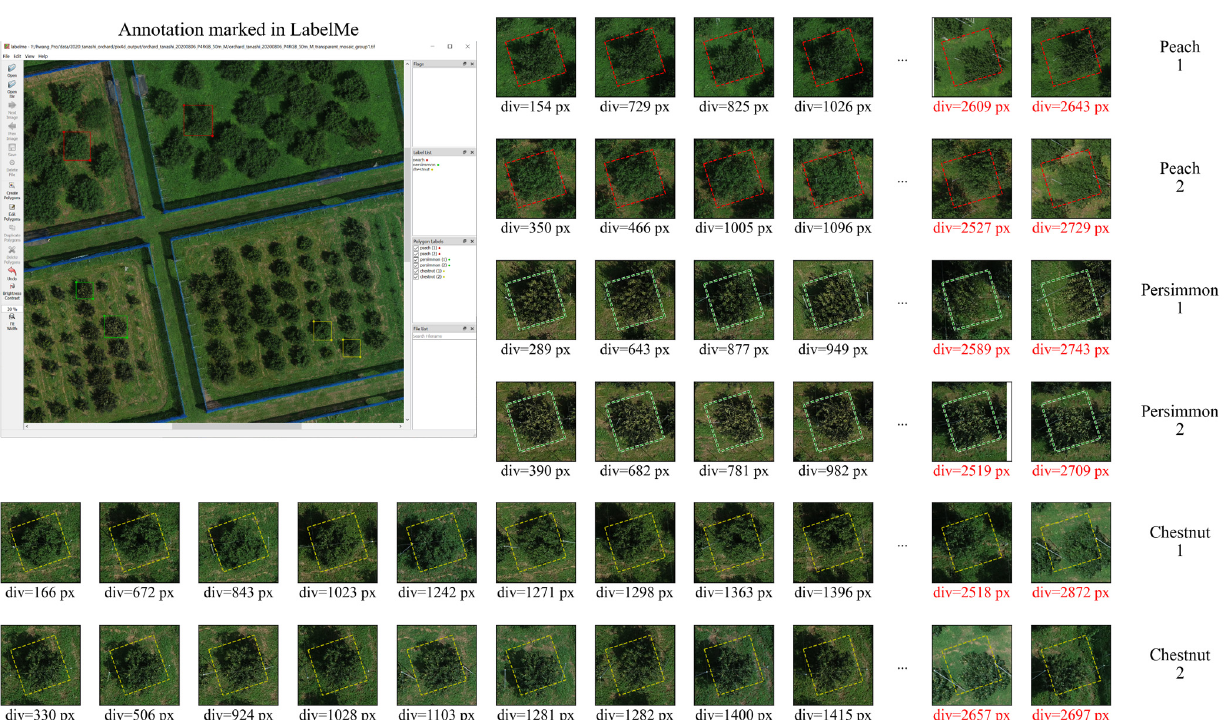
Figure 8. Potential usage of reverse calculation for individual-level training data annotation and augmentation in deep learning. The DOM file of dataset 4 (Orchard) was loaded into LabelMe directly, 6 rectangle annotations (2 for each species) were made, and the annotation JSON file was saved (left-corner screenshot). Reverse calculation was performed on all annotation rectangles for all raw images. “div” means the distance from the annotation center to the image center; smaller is closer.